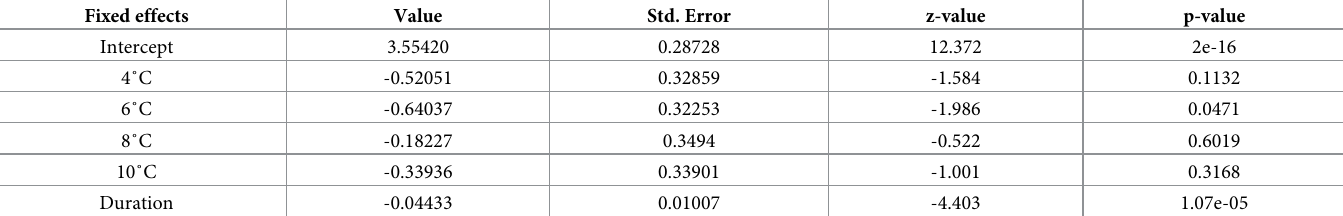
Table 1. Fixed-effects coefficients of a mixed-effect binomial model of the impact of temperature and duration of the survival of male Aedes aegypti on day 15 post- exposure. Fixed effects